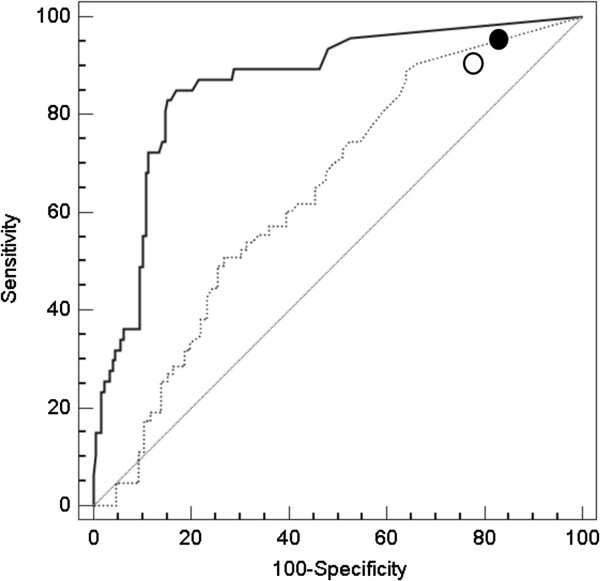
Diagnostic performance of faecal calprotectin testing. Receiver-operating characteristic (ROC) curve for clinically significant findings during EGD (dotted line) and colonoscopy (solid line). We also report the accuracy values for EPAGE criteria (EGD: open circle, colonoscopy: solid circle). The ROC curve represents the relationship between sensitivity and specificity for a considered outcome. EPAGE, European Panel on the Appropriateness of Gastrointestinal Endoscopy.